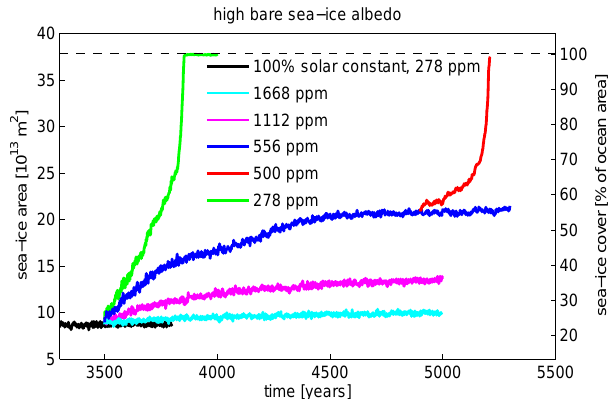
Fig. 1. Initiation of a Marinoan Snowball Earth in ECHAM5/MPI-OM with the model’s standard high bare sea-ice albedo (Voigt et al., 2011). Sea-ice dynamics and ocean heat transport are fully active. Time evolutionofannual-meanglobalsea-icecoverinresponsetoanabruptdecreaseofthesolarconstantfrom 100 % to 94 % and a simultaneous increase of atmospheric carbon dioxide. Note that the simulation for 500ppm CO 2 was run after Voigt et al. (2011) was published.